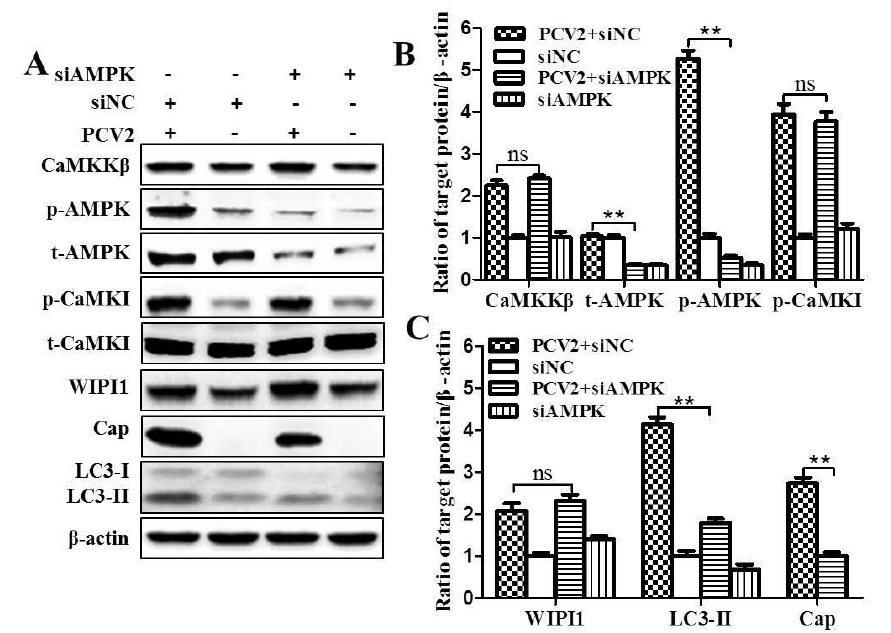
Figure 6. Silencing of AMPK downregulated LC3-II and Cap protein expression, but had no effect on CaMKKβ, CaMKI, and WIPI1. PK-15 cells were first transfected with siAMPK, then infected with PCV2 (MOI ≈ 1) and incubated for 36 h. The cell lysates were subjected to Western blotting. ( A ) Representative images of Western blotting for target proteins; ( B , C ) ratios of CaMKKβ, t-AMPK, p-AMPK, and p-CaMKI, WIPI1, LC3-II, and Cap to β-actin. Ratios of targeted proteins to β-actin were experiments (ns, p > 0.05; * p < 0.05; and ** p <